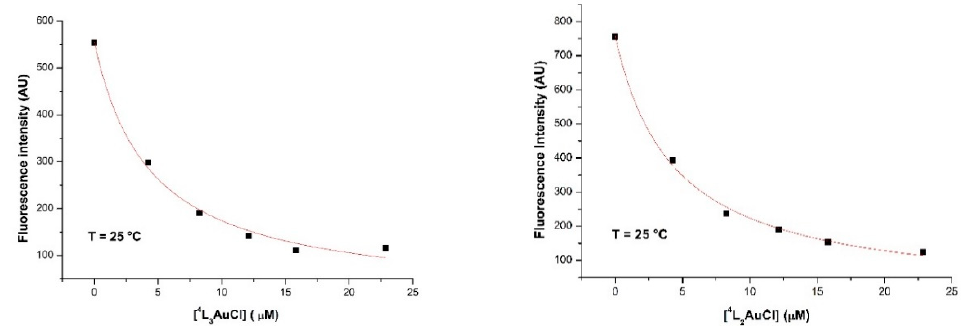
Figure 6. Fluorescence intensity values against added concentration of 4 L 3 AuCl ( left ) and 4 L 2 AuCl ( right ) at 25 ◦ C.